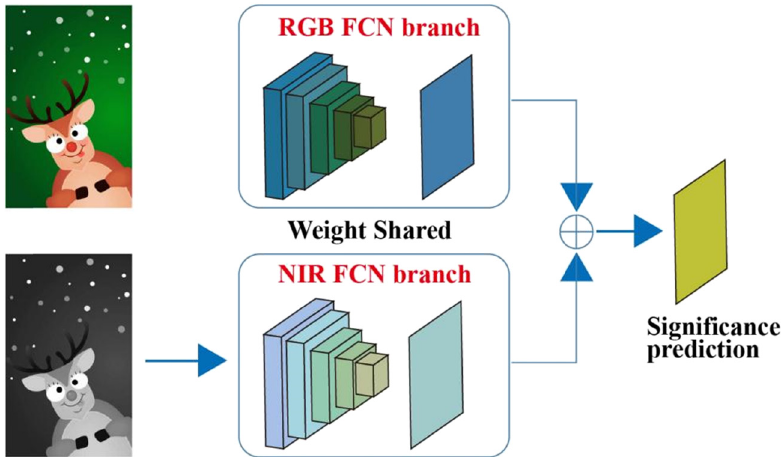
Figure 1: Double branch salient target detection network, input is RGB image and NIR